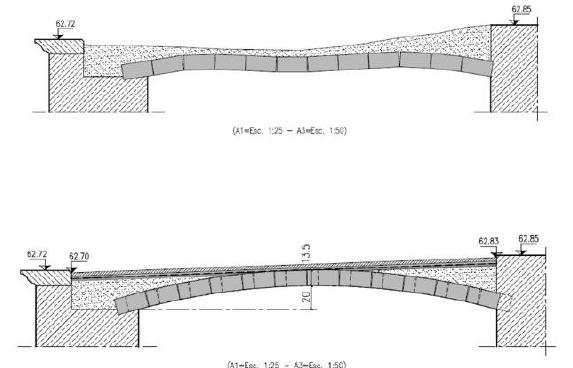
Figure 14. Cross section of the vault of the loggia. Top: existing, Bottom: to execute.